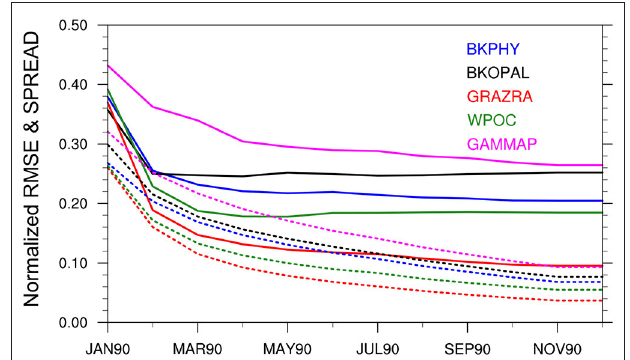
FIGURE 4 | Time evolution of global-averaged normalized RMSE (solid lines) and ensemble spread (dotted lines) of the BGC parameters from state-parameter estimation experiment using assimilation of time-varying observations (EnKF_PE). RMSE is calculated by comparing each member against the true values. Both RMSE and spread has been normalized by the global mean value of the true parameter.